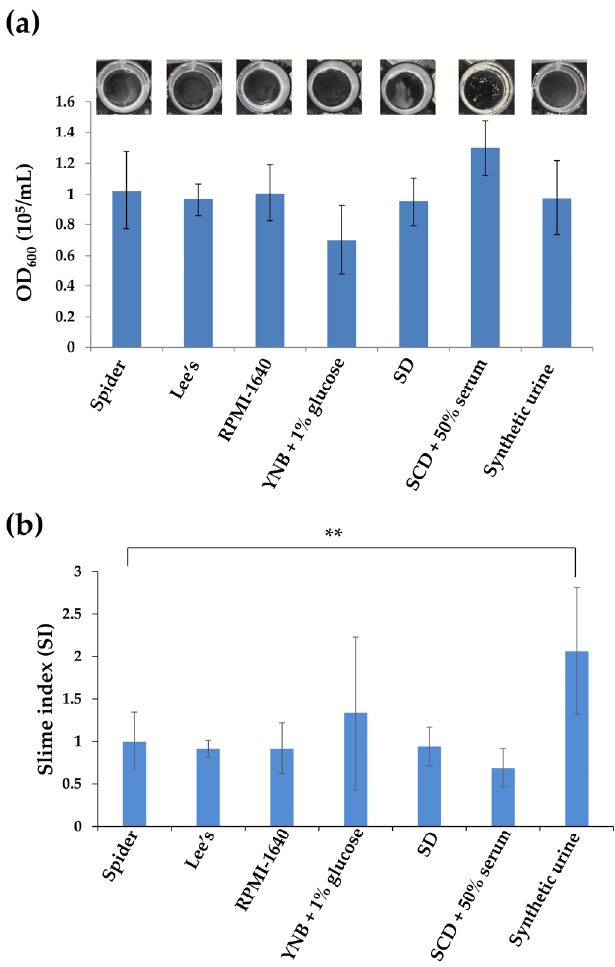
Figure 1. Effects of different culture conditions on C. tropicalis biofilm formation on the bottom of 12 ‐ well polystyrene plates: ( a ) Representative images of biofilm formation of the C. tropicalis wild ‐ type strain (MYA3404) on the bottom of 12 ‐ well polystyrene plates. Quantitative results showed that no medium induced cell adhesion and biofilm formation significantly compared to that of the Spider medium on the bottom of 12 ‐ well polystyrene plates. Values are the mean ± SD from six replicates. ( b ) C. tropicalis exhibited a significant increase in the slime index in synthetic urine medium. Values are the mean ± SD from six replicates. ** p < 0.01. Microorganisms 2020 , 8 , x FOR PEER REVIEW